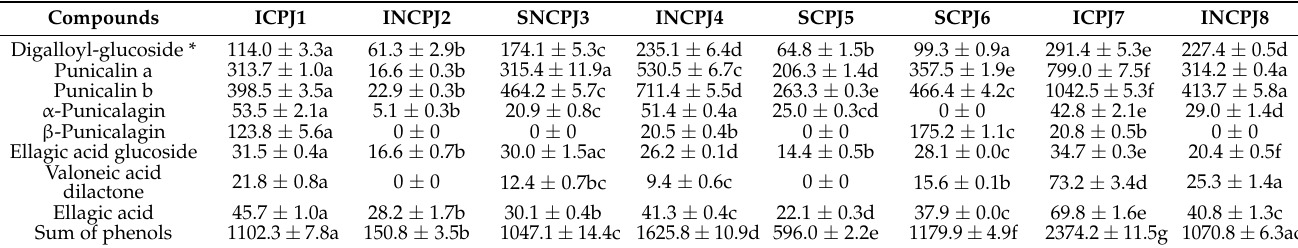
Table 3. Phenolic composition (mg/L) of